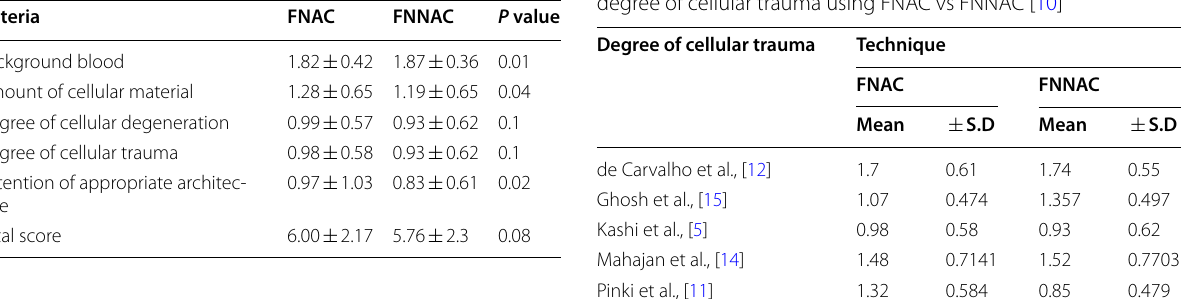
Table 8 Comparison between different studies regarding background blood using FNAC vs. FNNAC (Song etal.,[10]) Background blood Technique